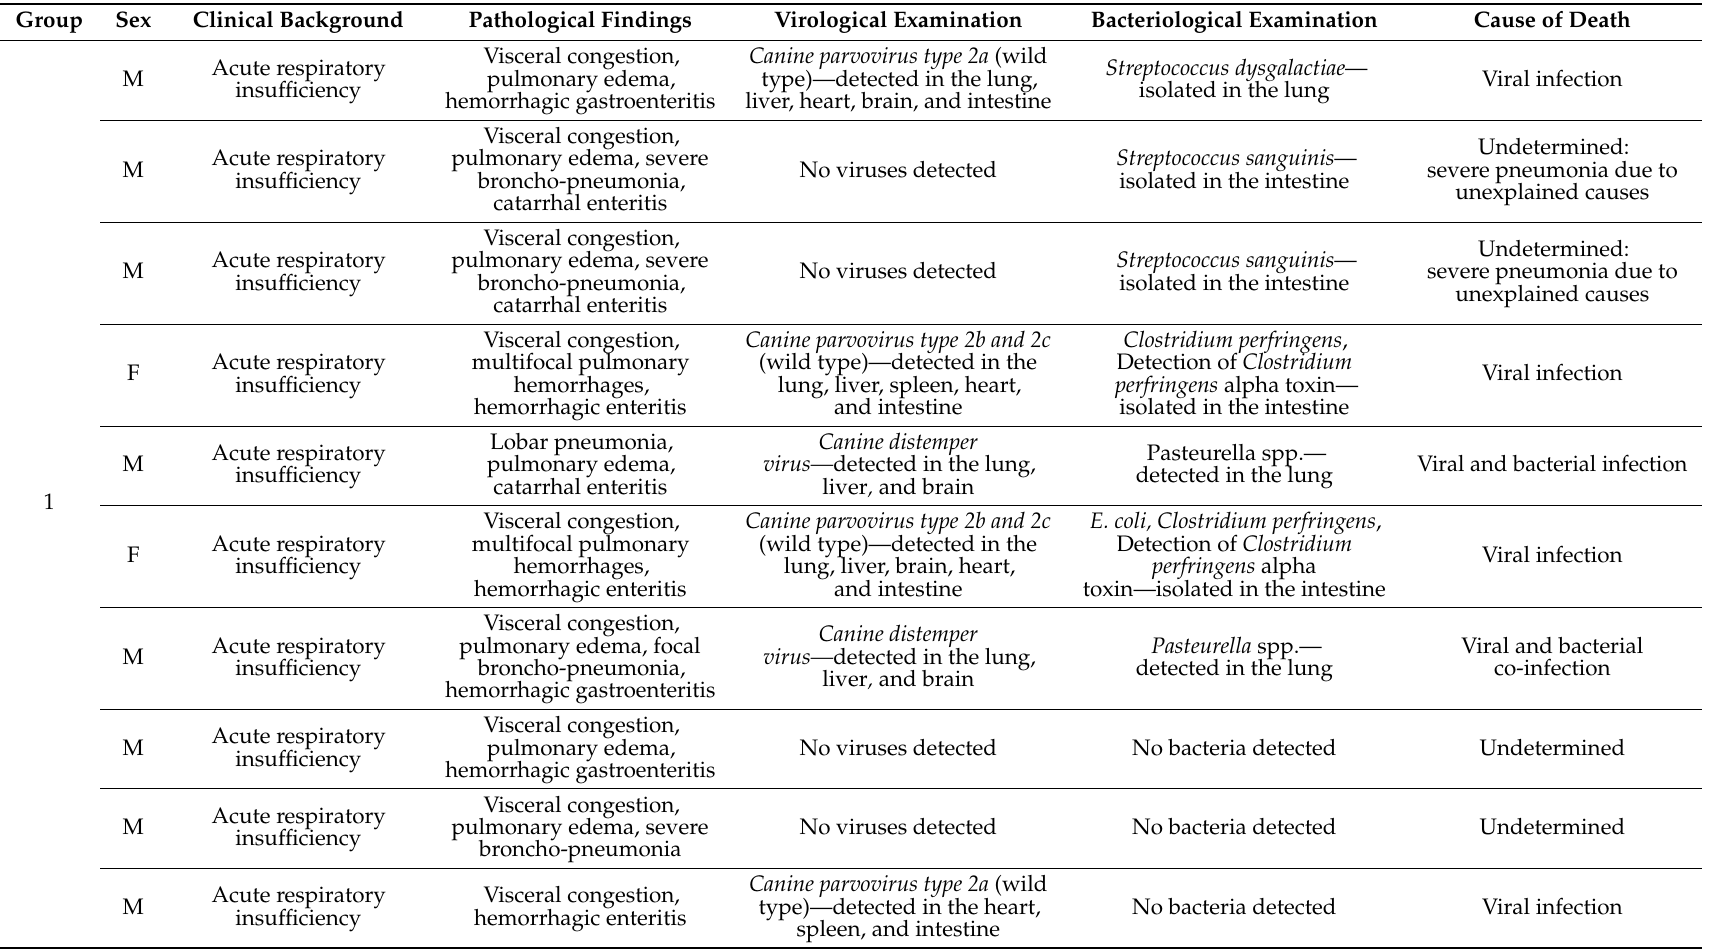
Table 3. Microbiological and anatomopathological findings of the studied